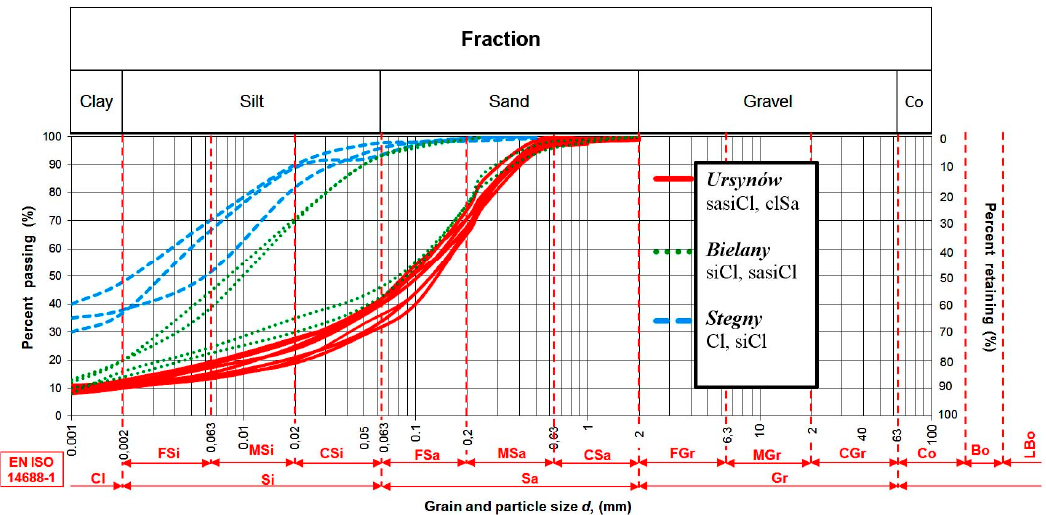
Figure 3. Grain size distribution of the tested cohesive soils. Table 2. Index properties of the tested cohesive soils.